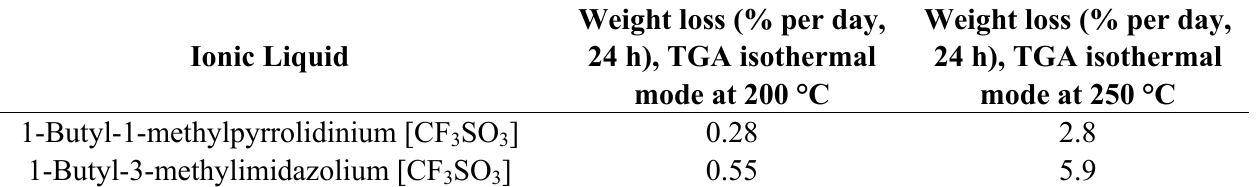
Table 1. Isothermal TGA measurements at 200 °C and 250